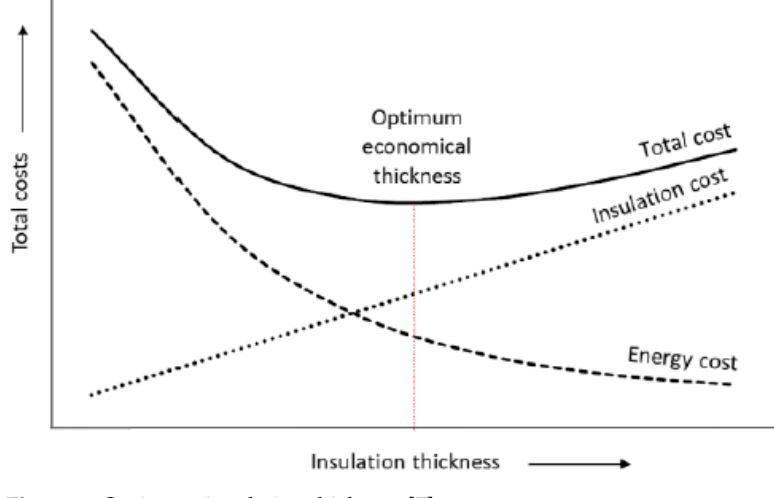
Figure 1. Optimum insulation thickness